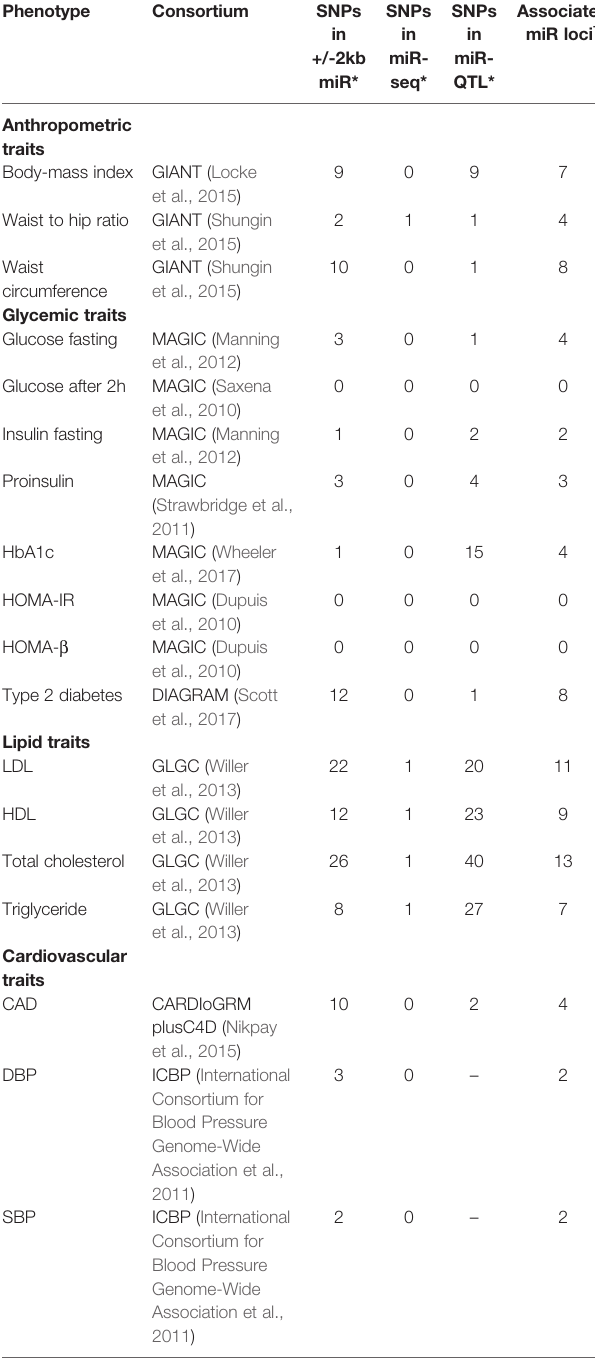
TABLE 1 | Description of genome-wide association studies (GWAS) of cardiometabolic traits and associated miRNA single-nucleotide polymorphisms